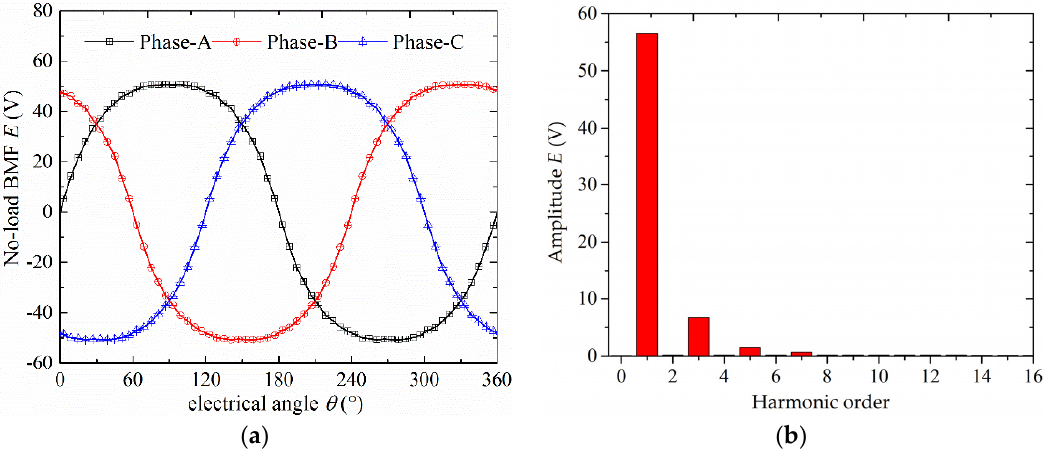
Figure 8. The no ‐ load back electromotive force of CS ‐ TFM: ( a ) waveform; and ( b ) harmonic Figure 8. The no-load back electromotive force of CS-TFM: ( a ) waveform; and ( b ) harmonic components.